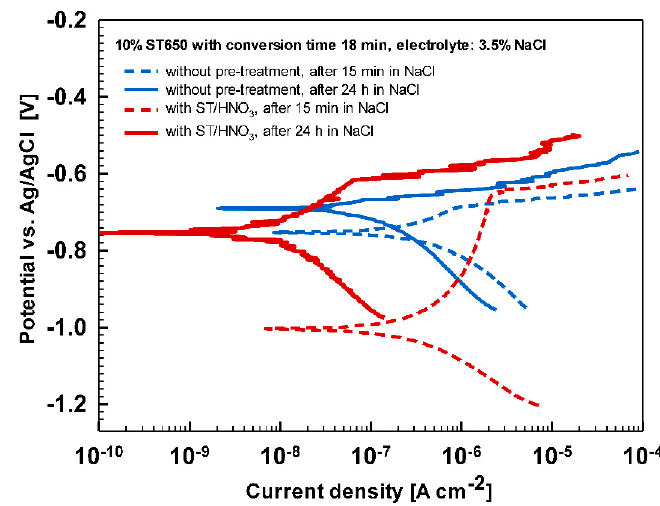
Figure A6. Potentiodynamic polarization curves recorded after 15 min and 24 h immersion in 3.5 wt.% NaCl for AA3003 samples coated with 10% ST650 coating prepared for 18 min at room temperature. Samples were prepared with and without chemical pre-treatment using ST / HNO 3 . Electrochemical data deduced from the curves are presented in Table A2. Table A2. Polarization resistance ( R p ), corrosion potential ( E corr ), corrosion current density ( j corr ), breakdown potential ( E bd ) and Δ E = | E bd – E corr | measured in 3.5 wt.% NaCl as a function of sample pre-treatment (Figure A6).